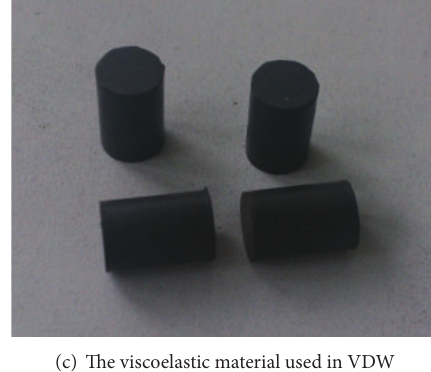
Figure 1: Temperature scan tester and test specimen for viscoelastic damping